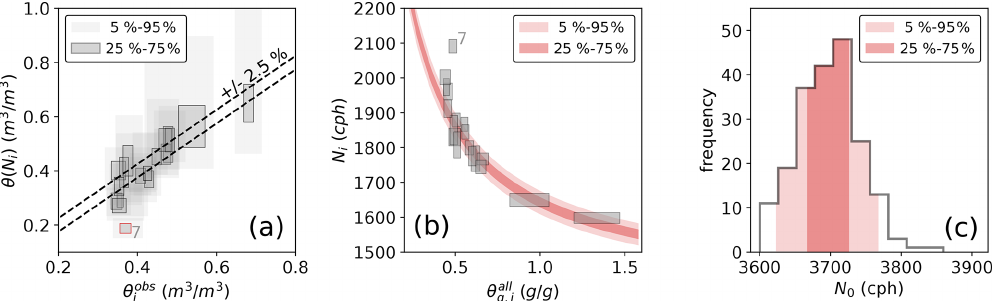
Figure 4. Results of the Monte Carlo analysis: (a) shows θ(N i ) versus θ obs , while (b) shows the corrected neutron intensities N i over i the gravimetric soil water equivalent θ all . The dark grey shaded areas represent the interquartile ranges of these variables based on the g , i 200 realizations in the Monte Carlo analysis. The horizontal and vertical extents of the dark grey shaded areas are used to measure the local uncertainties in these variables, where the term “local” refers to the uncertainty for a specific sensor footprint i . The light grey shaded areas in ( a ) show the inner 90% of the realizations for illustrative purposes only. (c) shows the distribution of all 200 N 0 values, highlighting the interquartile range in dark red and the inner 90% in light red. Accordingly, the dark and light red shaded areas in (b) indicate the range of the Desilets function when using the interquartile range and the inner 90% of N 0 realizations, respectively.